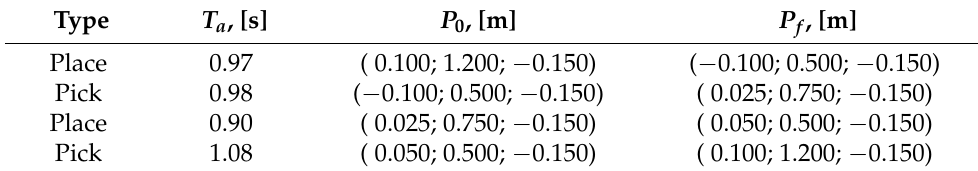
Figure 7. Pick-and-place reference task. Table 1. Main parameters of the reference working cycle.